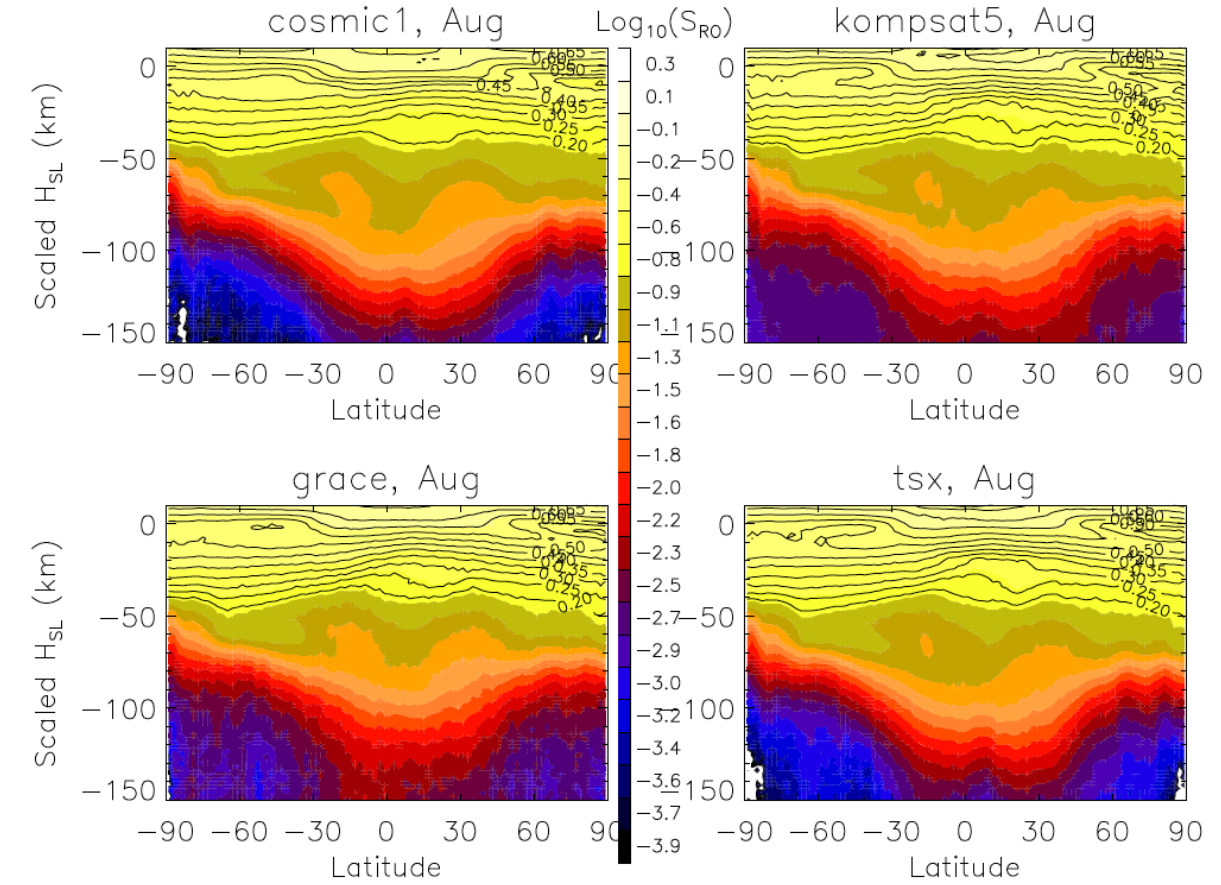
Figure 6. Mean August S RO from COSMIC1 (810 km), KOMPSAT5 (560 km), GRACE (300–500 km), and TSX (520 km) as a function of 𝐻̂ 𝑆𝐿 . The S RO amplitude is colored in a Log 10 scale to highlight very small values at deep 𝐻̂ 𝑆𝐿 , whereas contour lines represent a linear scale of S RO .